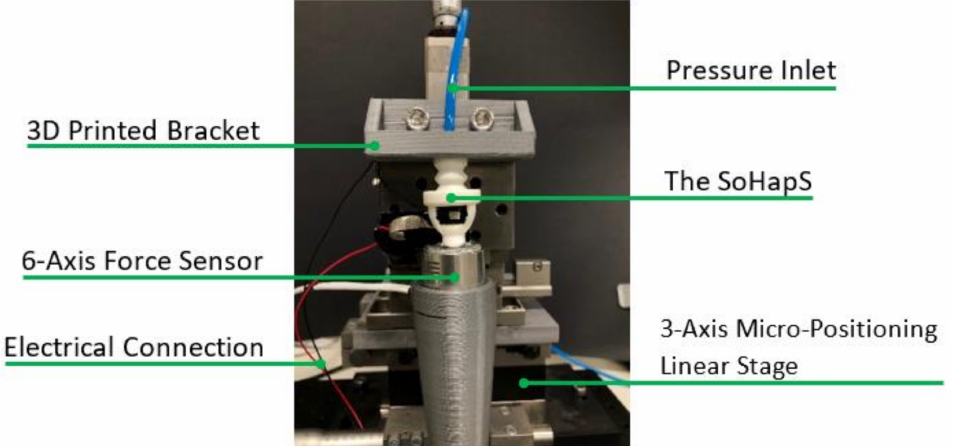
Figure 3. Experimental setup for characterization of